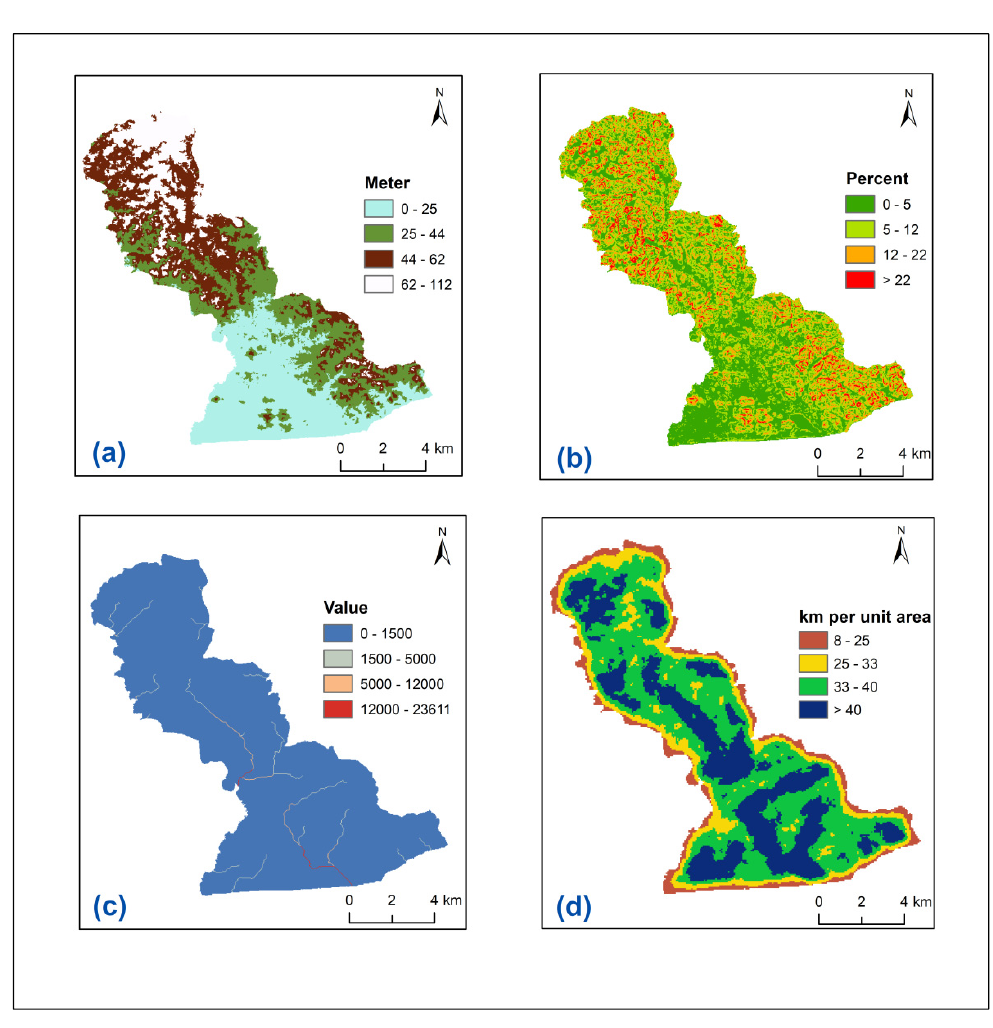
Figure 3. Four factors considered for flood hazard index: ( a ) elevation of CCM; ( b ) slope of CCM; ( c ) flow accumulation of CCM; ( d ) stream density of CCM.